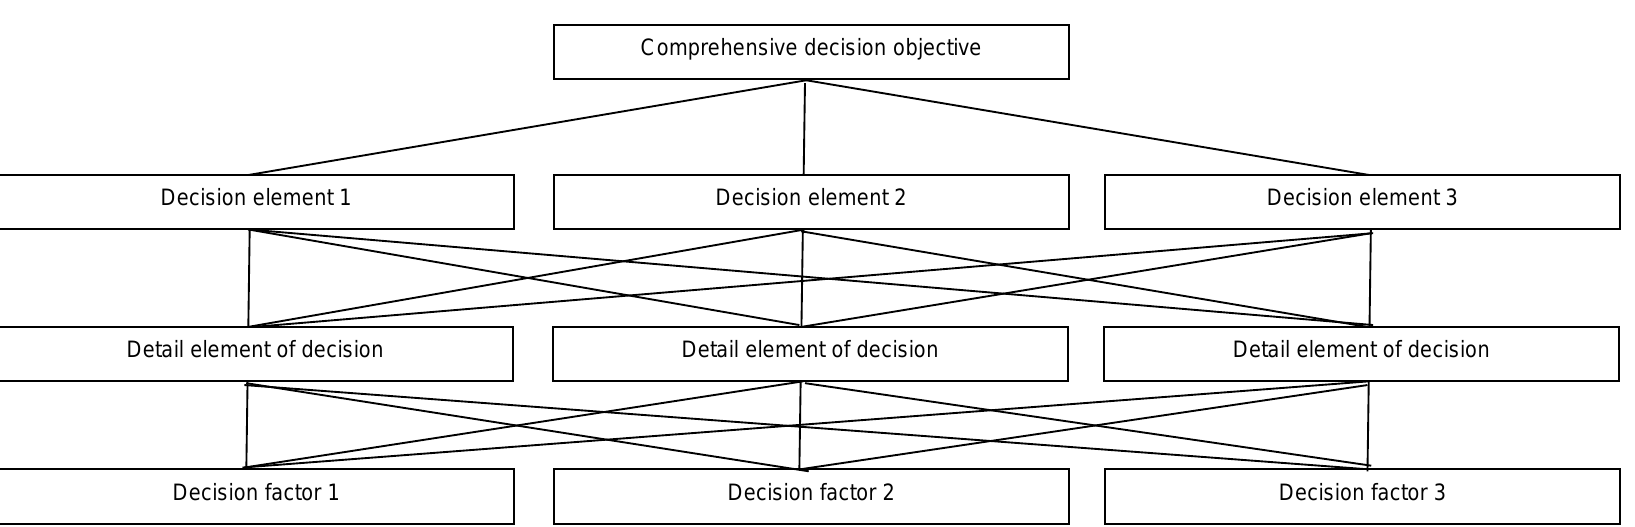
Figure 1. Standard hierarchy of the analytic hierarchy process